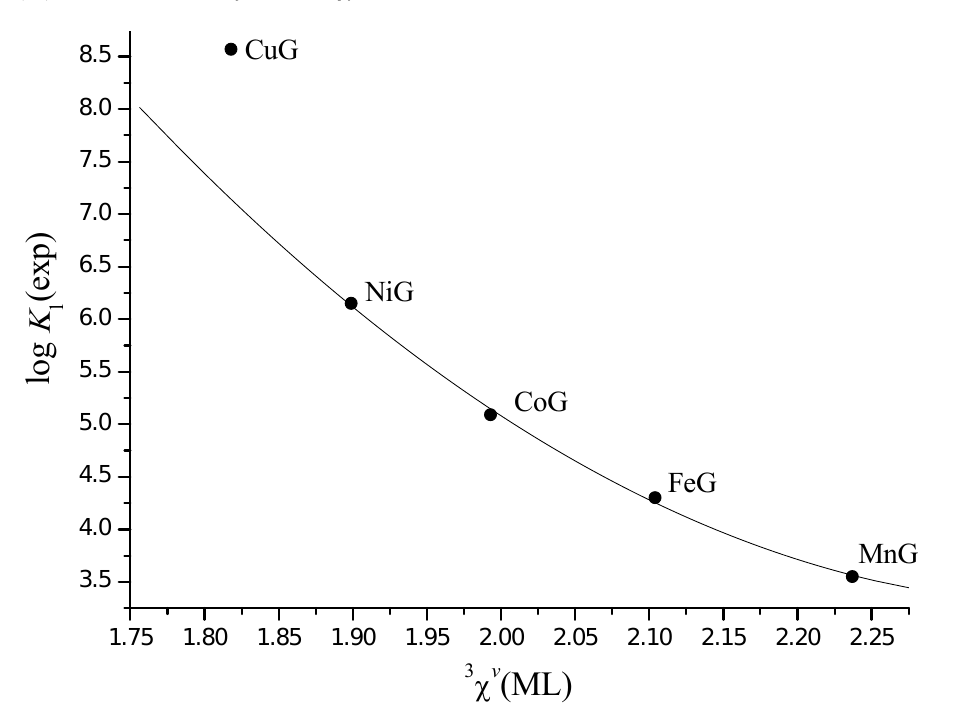
Figure 4. Quadratic dependence of log K glycine (G) on connectivity index 3 χ v .